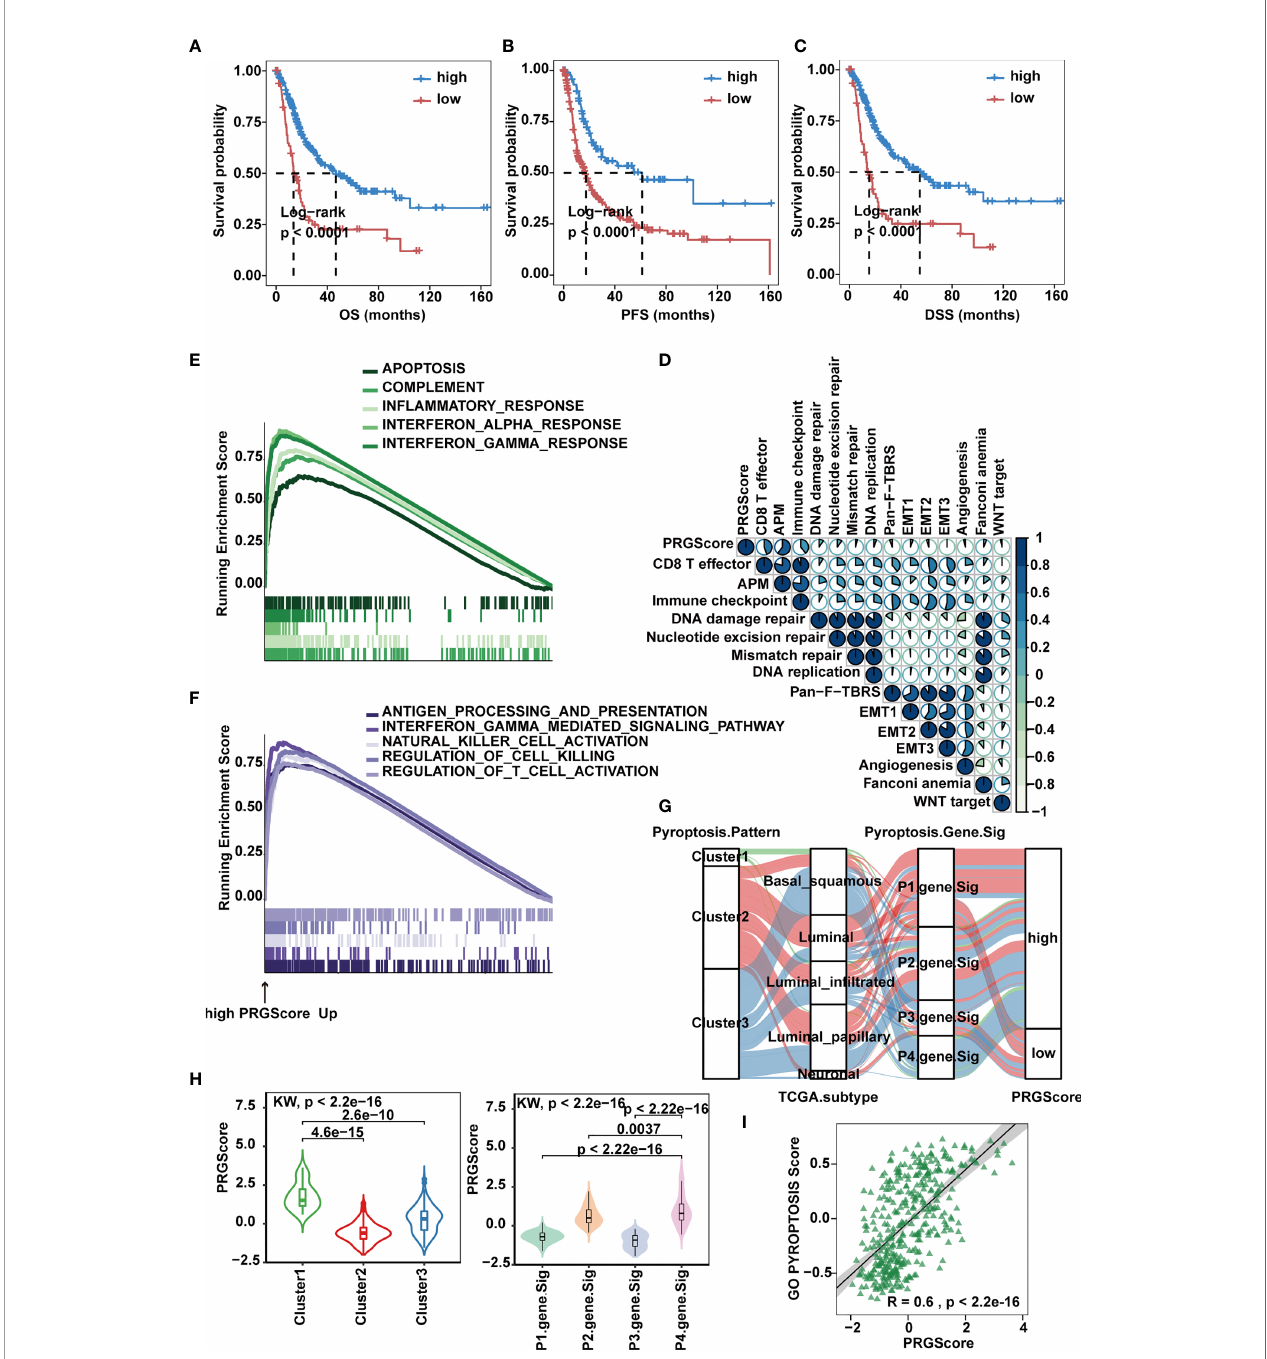
FIGURE 5 | Quanti fi cation of pyroptosis signatures based on PRGScore in the TCGA-MIBC cohort. (A – C) Survival analysis for overall survival (OS) (A) , progression- free survival (PFS) (B) and disease-speci fi c survival (DSS) (C) for patients with high and low PRGScores in the TCGA-MIBC cohort. (D) Correlations between PRGScore and gene signatures linked to EMT, immune checkpoint, mismatch repair, and immune activation in the TCGA-MIBC cohort. (E) GSEA identi fi ed apoptosis, complement, in fl ammatory response, interferon a response and interferon l response enriched in the high PRGScore group based on the HALLMARK pathway. (F) GSEA identi fi ed immune activation-related pathways (such as the interferon gamma-mediated signaling pathway, antigen processing and presentation, natural killer cell activation, regulation of cell killing and regulation of T cell activation) enriched in the high PRGScore group based on the GO pathway. (G) Alluvial diagram showing the connection of pyroptosis patterns, TCGA-MIBC molecular subtypes, pyroptosis-related gene signature and PRGScore. (H) Differences in PRGScore among three pyroptosis patterns (left) and among four pyroptosis-related gene signatures (right) in the TCGA-MIBC cohort. The Kruskal-Wallis test was used to compare the signi fi cant differences between three gene clusters. (I) Scatter plots depicting the signi fi cantly positive correlation between PRGScore and GO pyroptosis signature score in the TCGA-MIBC